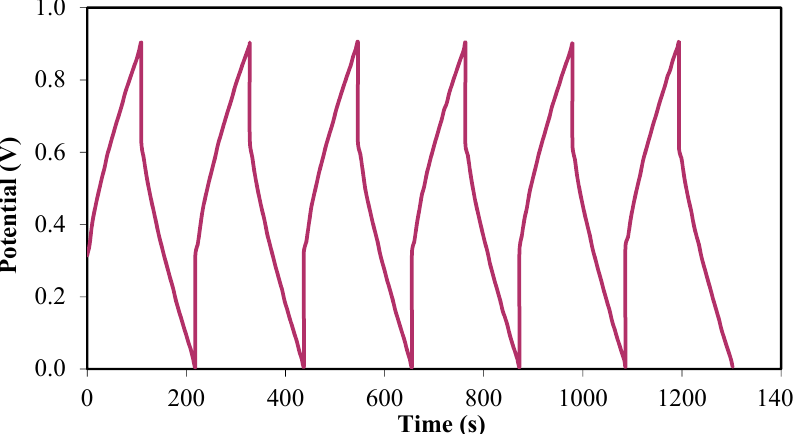
Figure 6. Charge–discharge profile for the fabricated EDLC at initial cycles.